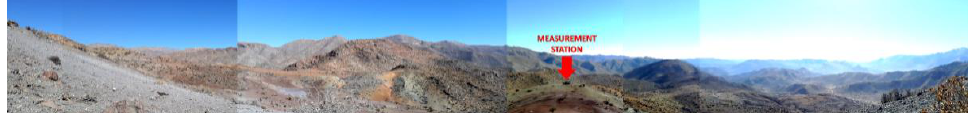
Figure 4. Surroundings for the measurement station at the site of the total eclipse (SHA).